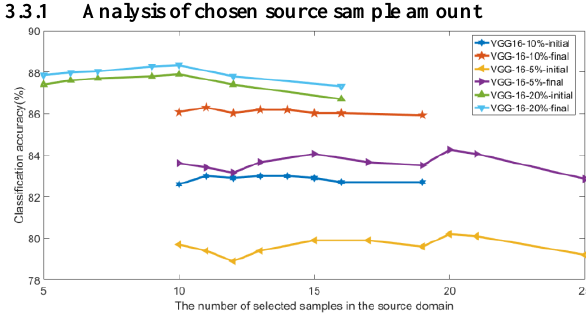
Figure 7. The experimental results of VGG-16 architecture with diverse chosen source sample number.